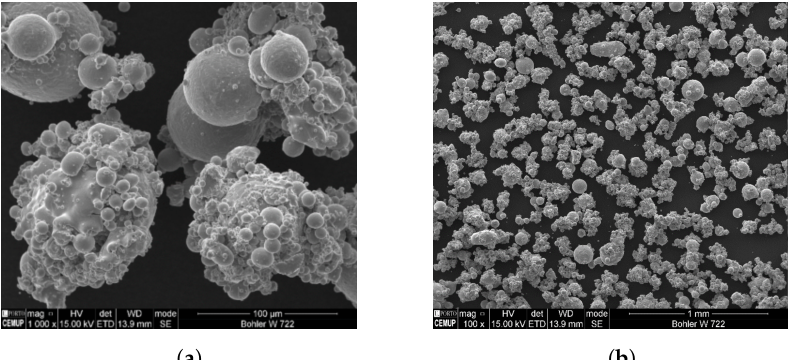
Figure 1. Powder morphology, as obtained through scanning electron microscopy: ( a ) highlights the powder particle agglomerates that characterise the used powder; ( b ) shows a general configuration of the analysed powder sample.